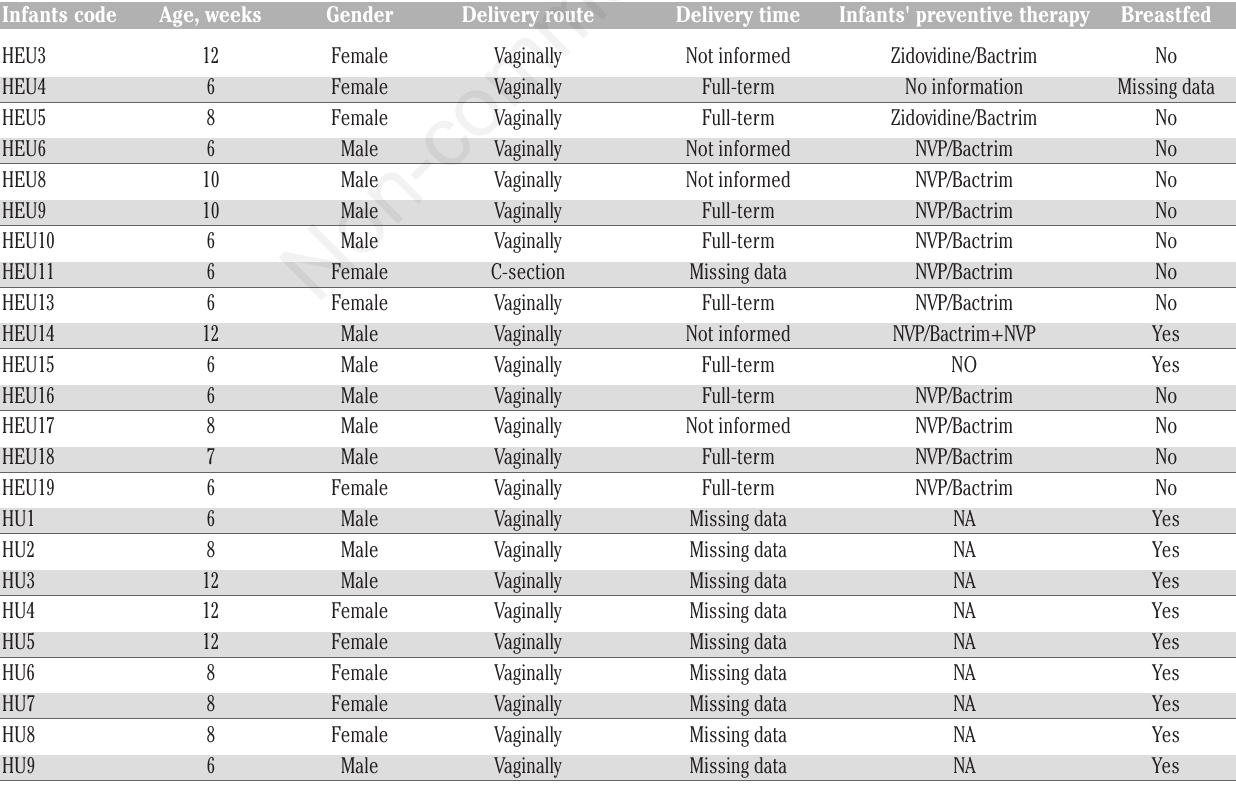
Table 1. HIV-exposed and unexposed infants information (age, gender delivery mode, preventive therapy, etc.) Infants code